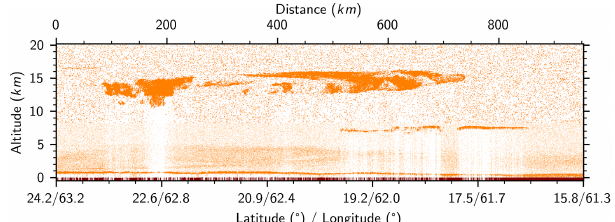
Figure 3. Pixels of Fig. 1 where the lidar signal is above the range- dependent threshold computed from Eq. (3) with k = 2 are shown in orange. Brown pixels show surface